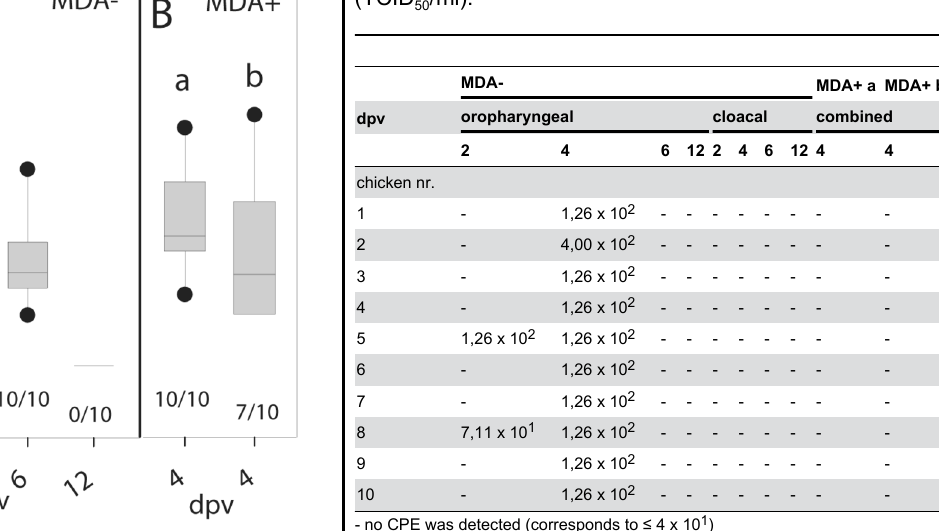
Table 1. Shedding of infectious virus after vaccination (TCID 50